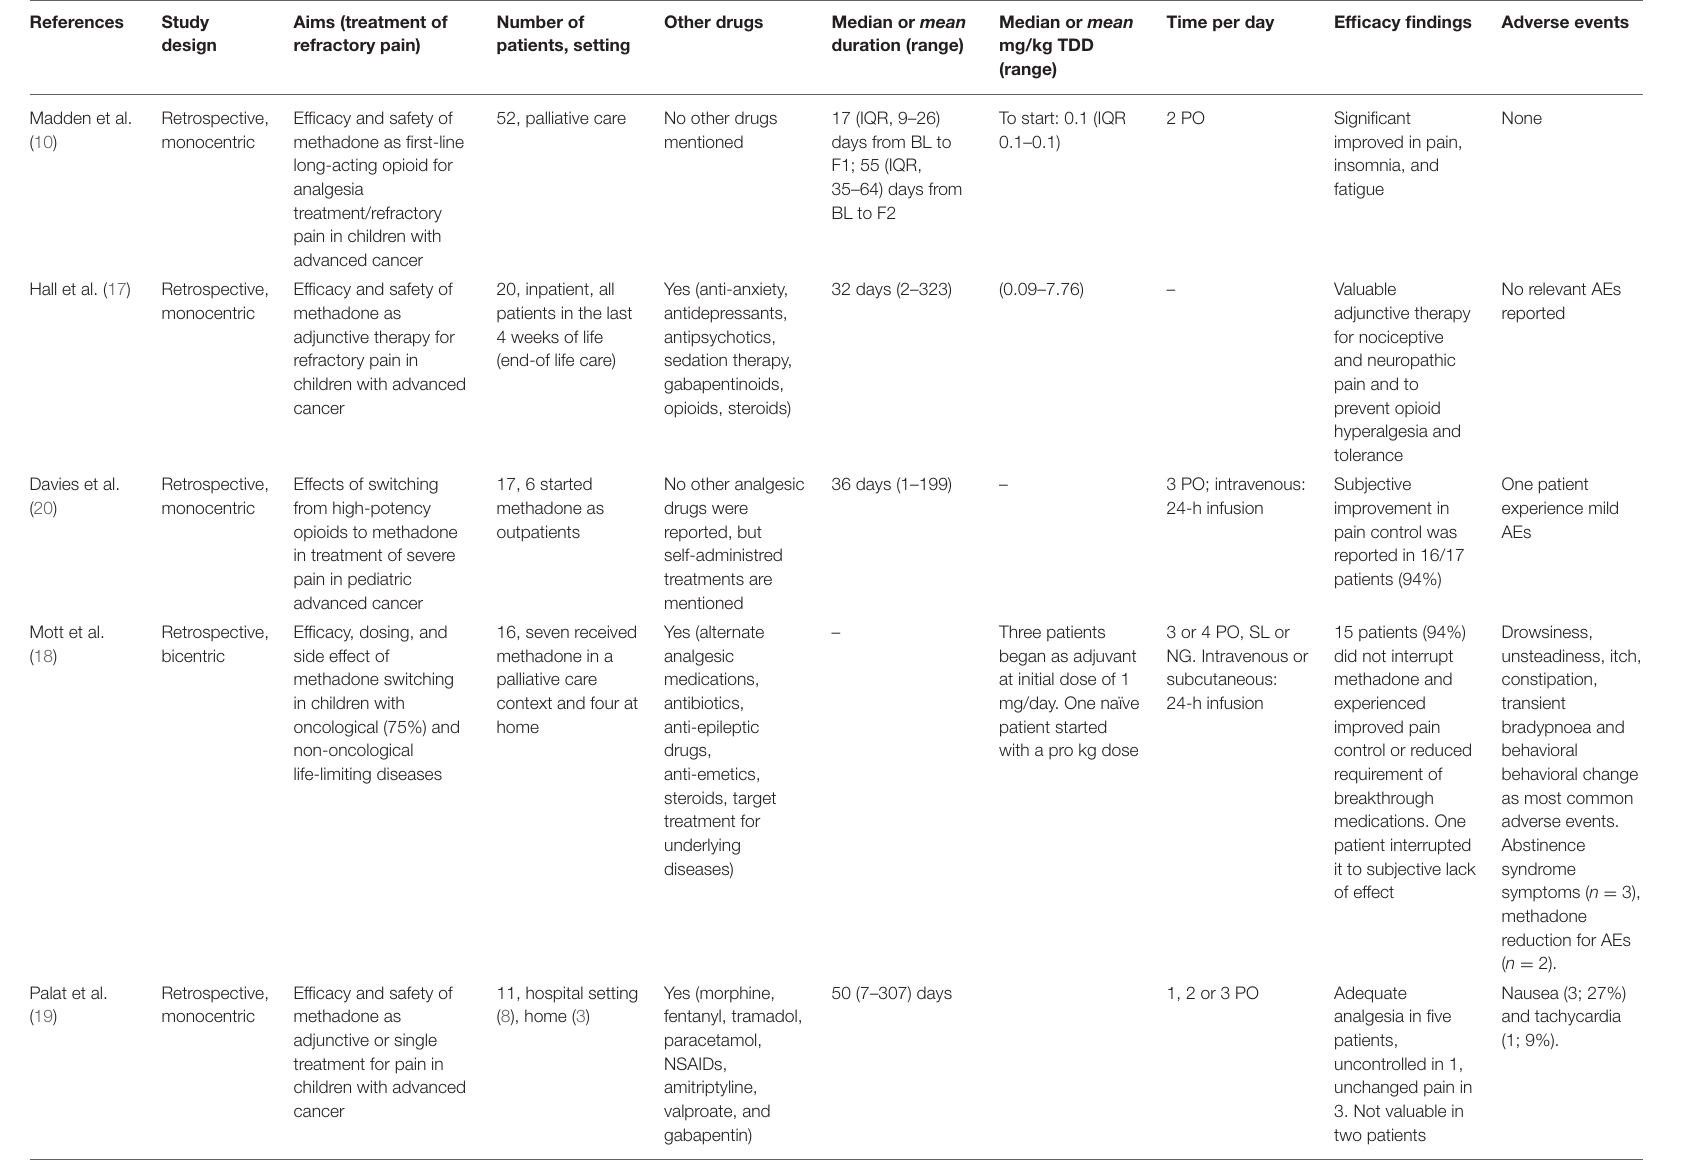
TABLE 1 | Studies included in the